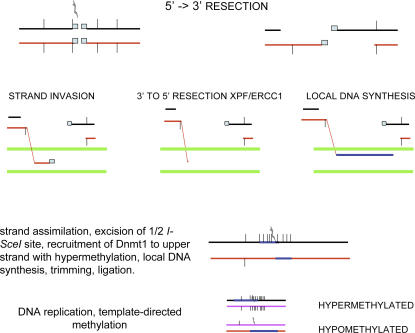
HR DNA Molecules Are Marked by Methylation Pattern ChangesA drawing illustrates how HR affects methylation. The case shown is a gene conversion event following a DSB at a specific chromosomal site with the GFP gene. The invasion of GFP cassette II (green) maintains the linearity of the DNA molecule at the I-SceI site. Methylation of only one repaired strand (the leading strand, in this specific example) is followed by an intermediate hemimethylated DNA molecule. Replication of this molecule yields fully methylated and nonmethylated DNA molecules. We suggest that Dnmt1 and the DSB repair machinery (BASC, BRCA1-associated surveillance complex) are strand-selective.